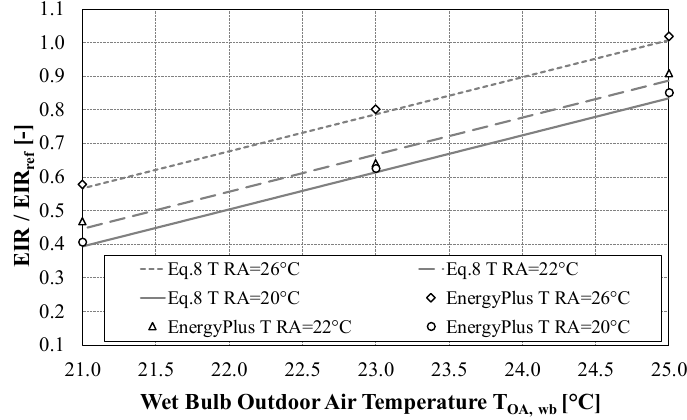
Figure 7. COP in heating mode: comparison between EnergyPlus simulations and equation fit model approach.